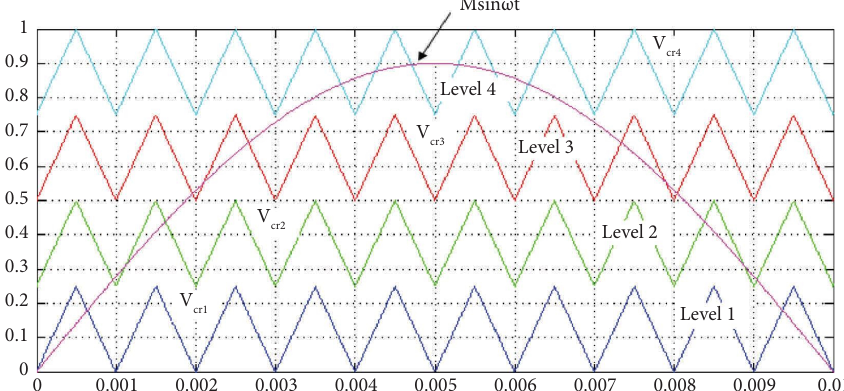
Figure 14: Pulse width modulation phase disposition technique (PD-PWM).